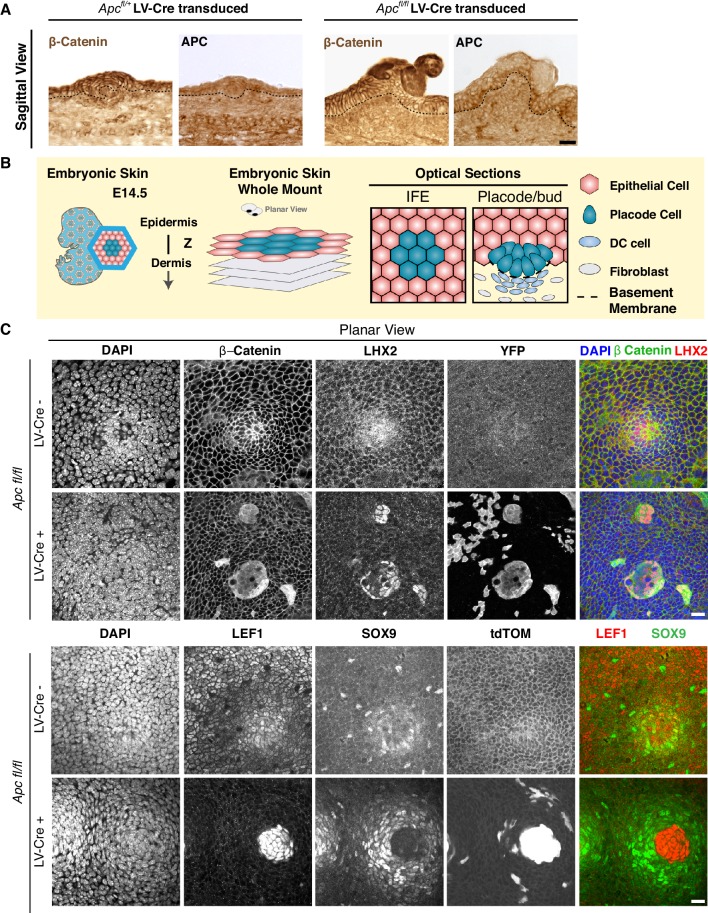
Apc-null clusters show properties of hair follicles arrested at the placode stage.(A) Sagittal sections of embryonic skin subjected to immunohistochemistry with antibodies against β-Catenin and APC. Note that reduced APC immunostaining coincides with broadened elevated β-Catenin, reflective of enhanced WNT signaling throughout the cluster. (B) Schematic of whole-mount analysis from embryonic skin with two examples of sampling of optical sections. (C) Apcfl/fl and Apcfl/+; Rosa26-lox-stop-lox-YFP or tdTomato embryos were transduced with LV-Cre and subjected to whole-mount immunofluorescence microscopy. Note that when cells form a distinct cluster, they strongly immunolabel for nuclear β-catenin and LEF1, as well as WNThi progenitor marker LHX2, features of hair placodes, but they are negative for WNTlo hair bud marker SOX9. The absence of WNTloSOX9+ cells within the cluster indicates its failure to progress to the hair follicles bud stage. By contrast, the wild-type cells surrounding these clusters were SOX9+, reflective of the impact of WNThiLHX2+ surrounding the clusters. This is most likely due to the high level of WNT-inhibitors expressed by neighboring Apc-null cells as shown in Figure 2. Scale bar, 20 μm for all frames.